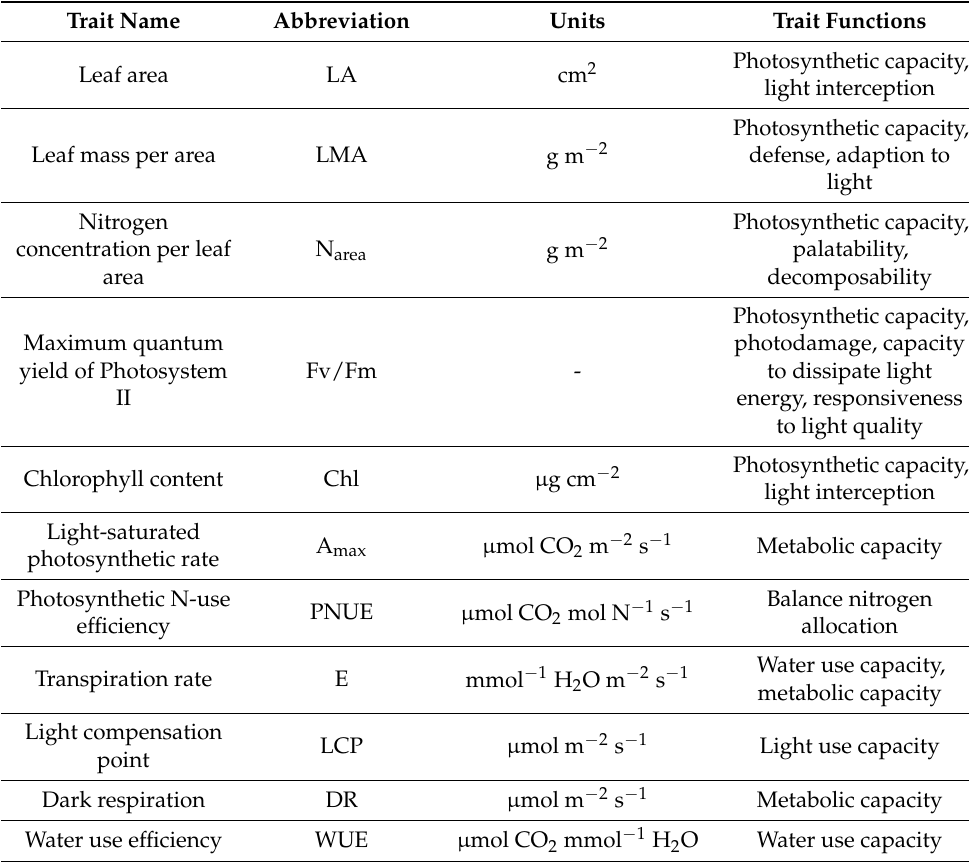
Table 2. List of leaf traits measured in Miyake-jima and categorized according to their function.